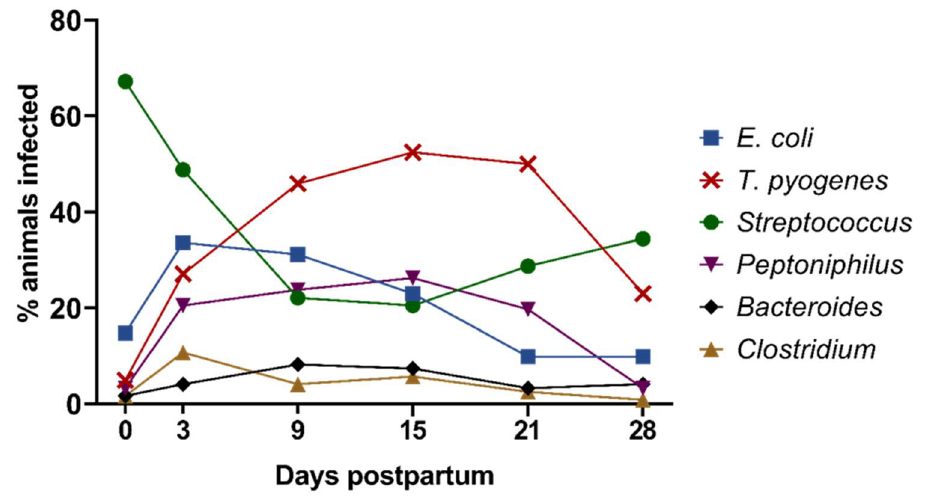
Figure 3. Percentage of animals positive for E. coli , T. pyogenes , Streptococcus spp., Peptoniphilus spp., Bacteroides spp., and Clostridium spp. at the day of calving (day 0) and on days 3, 9, 15, 21, and 28 postpartum.